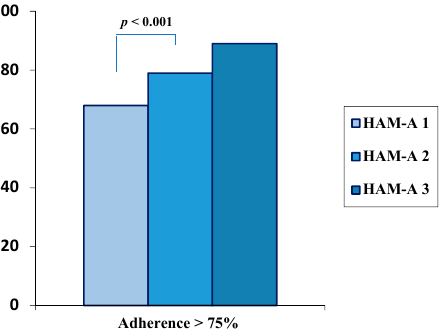
Figure 2. Adherence to weekly alendronate or risedronate in postmenopausal women according to tertiles of anxiety levels (HAM-A 1 < HAM-A 2 < HAM-A 3).